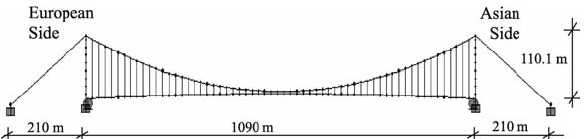
Fig. 11. 2D finite element model of Fatih Sultan Mehmet suspension bridge. Fig. 11. 2-D finite element model of Fatih Sultan Mehmet suspen- sion